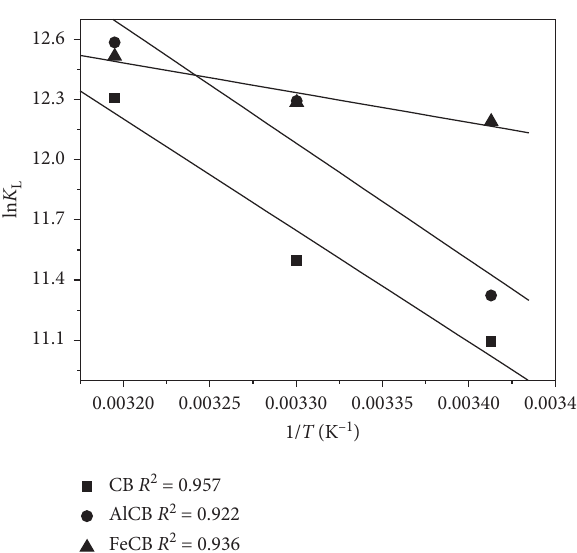
Figure 15: Plot of lnK